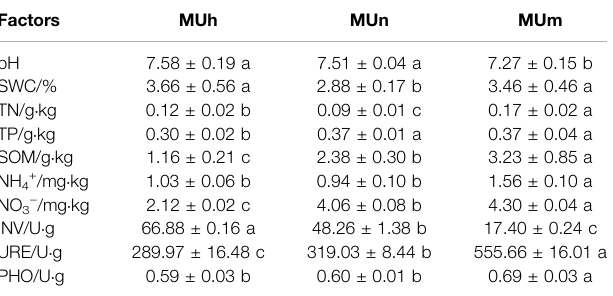
TABLE 3 | Soil properties of P. sylvestris with different age groups. Factors